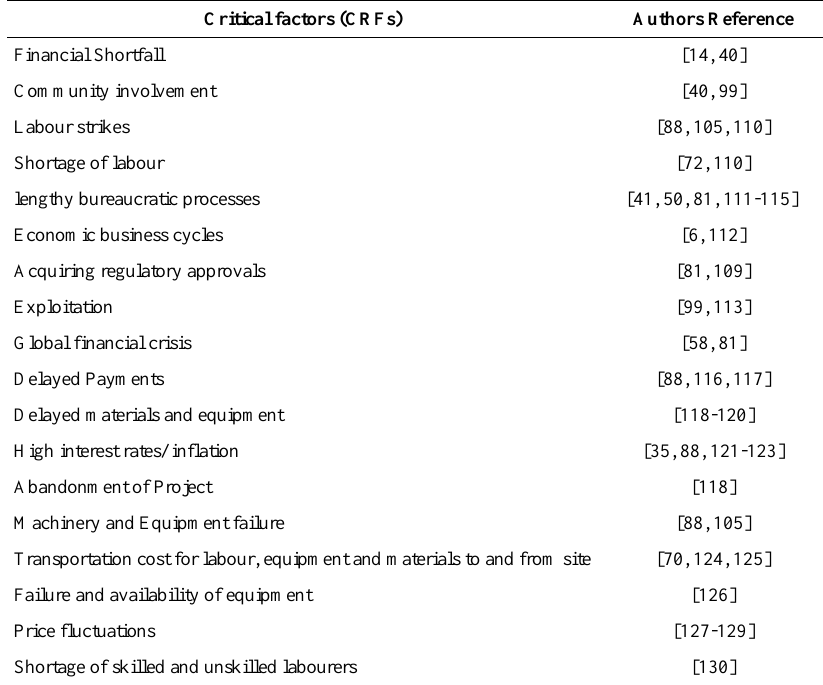
Table 3. Critical Risk Group (Root Cause) - Socio-Economical